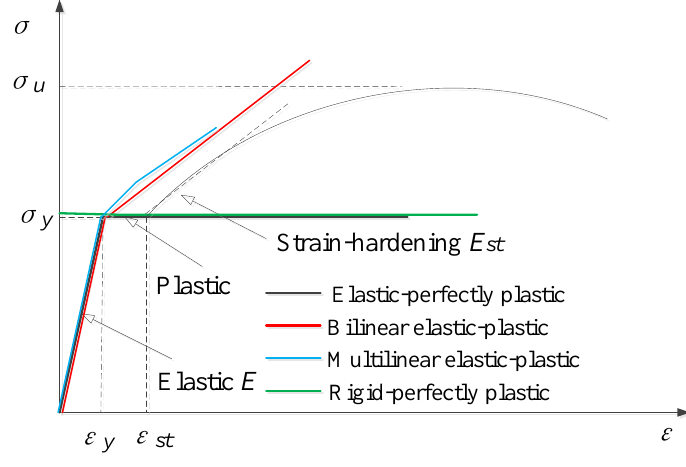
Figure 8. Quasi-static stress–strain relationship models.